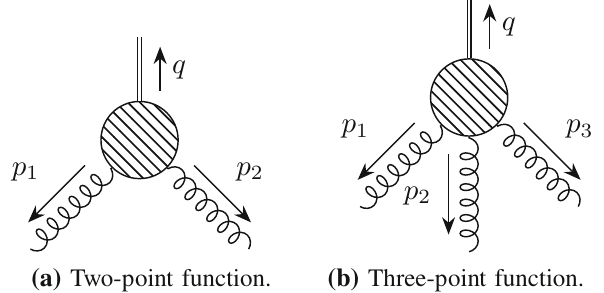
Fig. 1 Schematic representation of the needed two-point and three- point functions with insertion of an operator O i . The “blob” represents allpossibleconnectedtree-levelandone-loopgraphswithgivennumber of external legs instead of the standard − λ 0 tr ((∂ μ A μ )(∂ ν A ν )) and adds a Faddeev Popov term